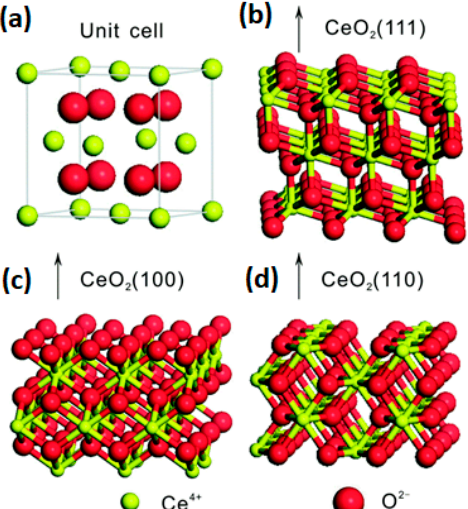
Figure 6. Structural models of CeO 2 ( a ) unit cell, ( b ) (111), ( c ) (100), and ( d ) (110) surfaces without structural optimizations. Reproduced with permission from Reference [106]. Copyright © 2014, Royal Society of Chemistry.